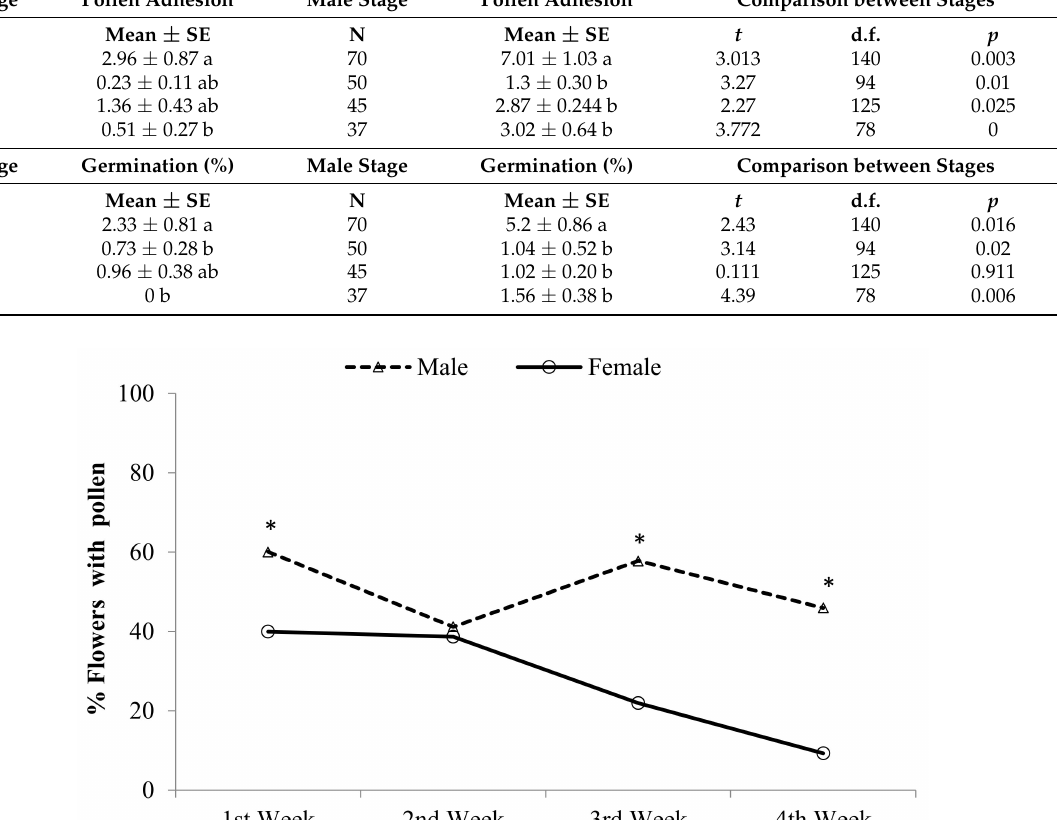
Figure 2. Percentage of avocado flowers at the male and female stages left to open pollination with at least one pollen grain on the stigma during the avocado flowering season. The asterisks indicate significant differences between male and female stages at p < 0.05 (Student ´ s t